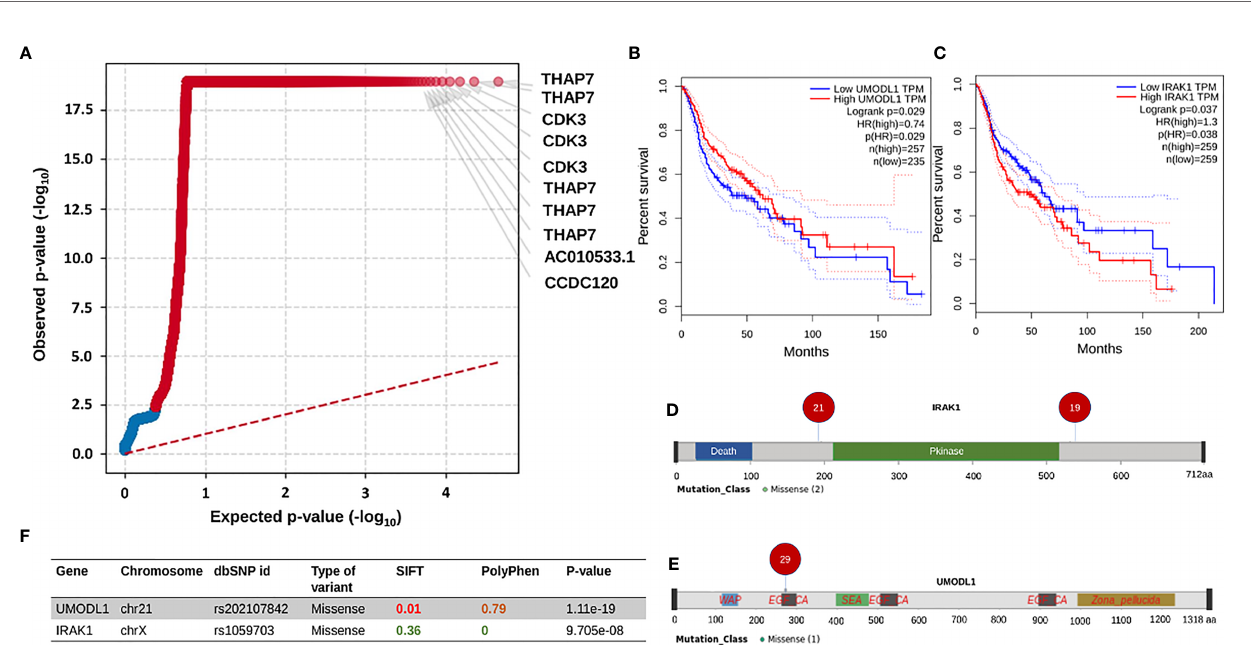
FIGURE 4 | This entire panel of fi gures represents results from driver genes prediction and the subsequent analyses performed. (A) This is a quantile plot generated by oncodriveclutstl that depicts signi fi cant driver genes predicted as per frequency of mutations. This plot shows THAP7 and CDK3 as the most signi fi cant driver genes. (B, C) Show expression-based survival plots of two more driver genes, UMODL1 and IRAK1, respectively, from the HNSCC dataset in GEPIA2 database. Both have a signi fi cant difference in survival probability between high and low expression categories. (F) Table showing the details of the UMODL1 and IRAK1 mutations. It can be seen that the missense mutations in both of them have been previously reported, are deleterious and probably damaging based on the SIFT and PolyPhen values. The p-value in the last column is the signi fi cance measure from oncodriveclustl prediction. (D, E) Are lollipop plots depicting the amino acid position and the number of patients of the missense mutations in UMODL1 and IRAK1 linear protein structures respectively.